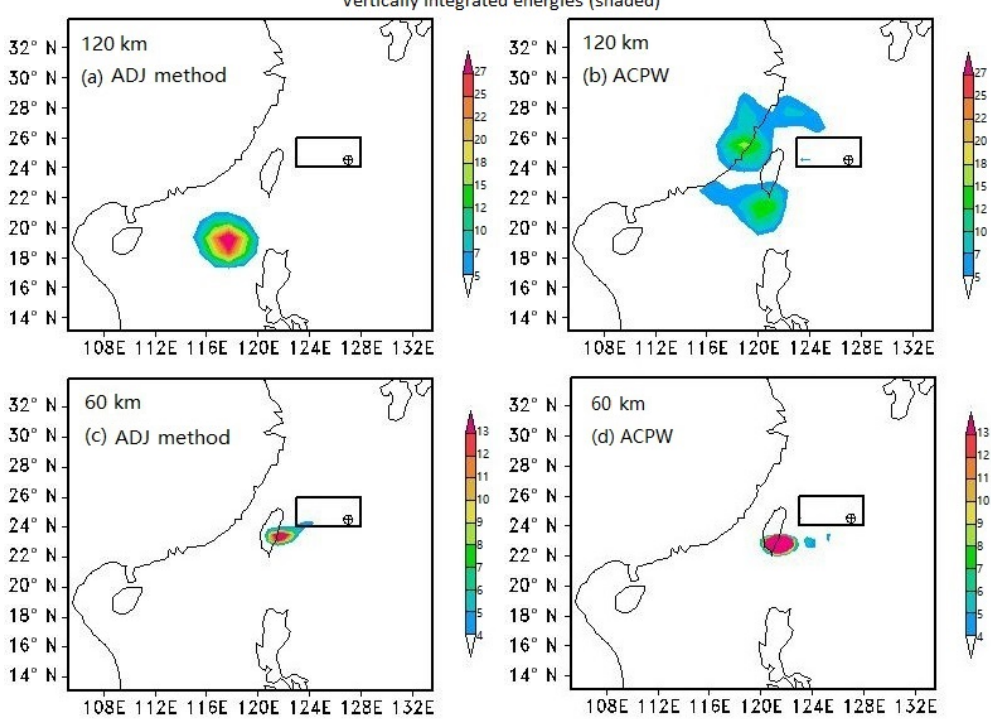
Figure 7. As described in Fig. 5, except where the shaded parts represent the vertically integrated energies (units: Jkg − 1 ).